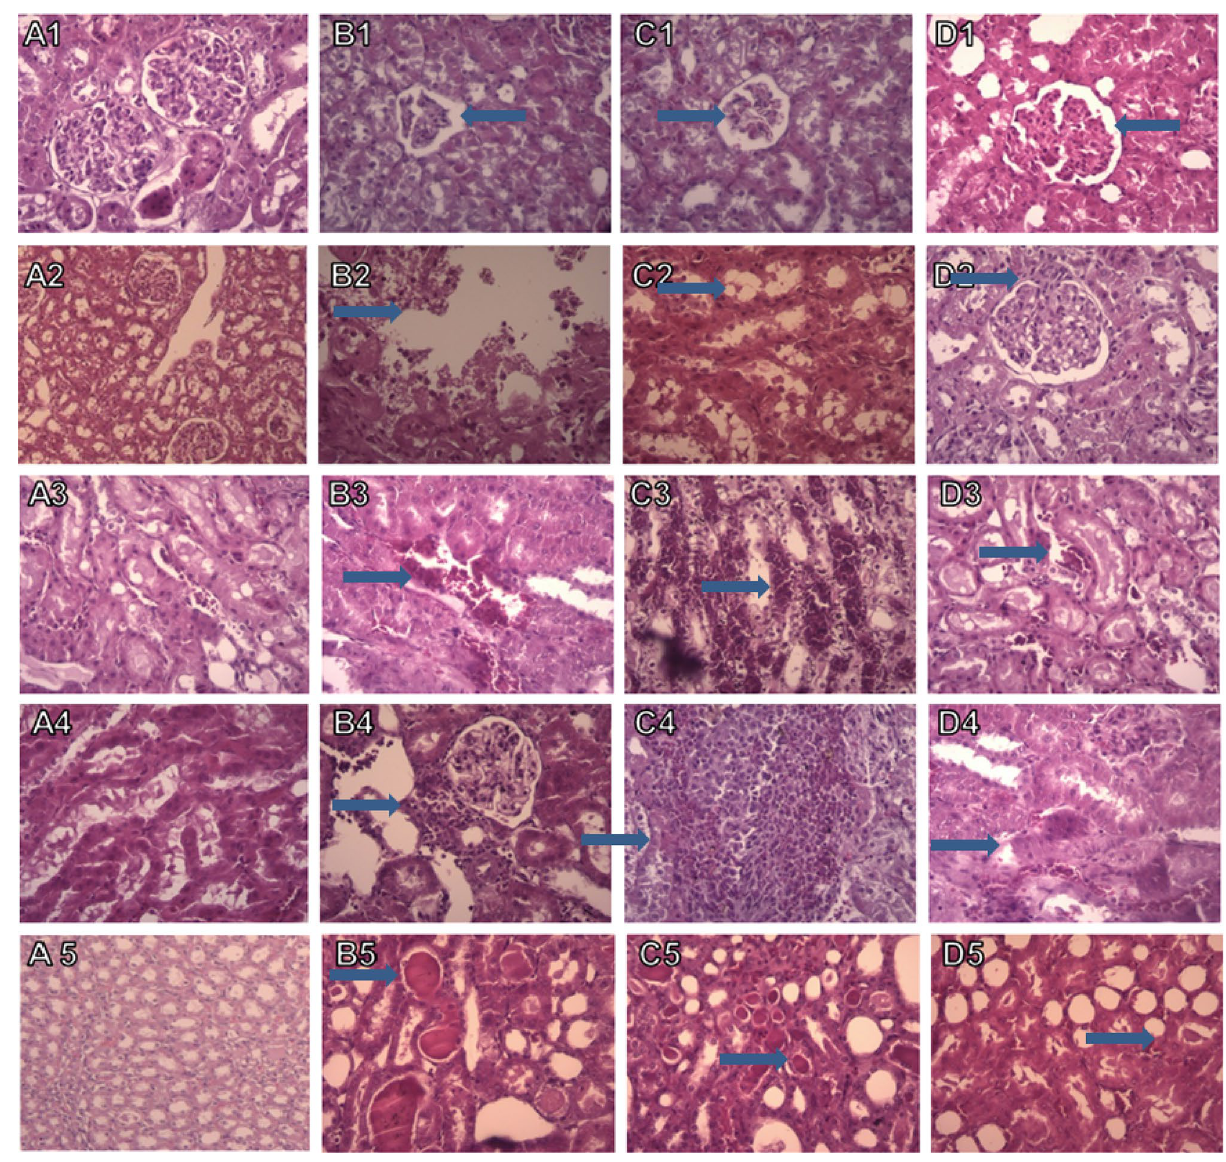
Figure 7. Light photomicrographs of the rats kidney sections (H&E). Kidney sections from control group showed normal renal morphology ( A1 – A5 ). Renal ischemia followed by 24 h of reperfusion caused severe histologic damages including reduction in the size of glomerular tuft, necrosis, medullary vascular congestion, inflammation and cast were observed in I/R ( B1 – B5 ) and I/R empty niosome ( C1 – C5 ) groups. These I/R- induced histologic damages were reduced in animals treated with crocin-contain nanoniosomes compared with untreated groups (Magnification